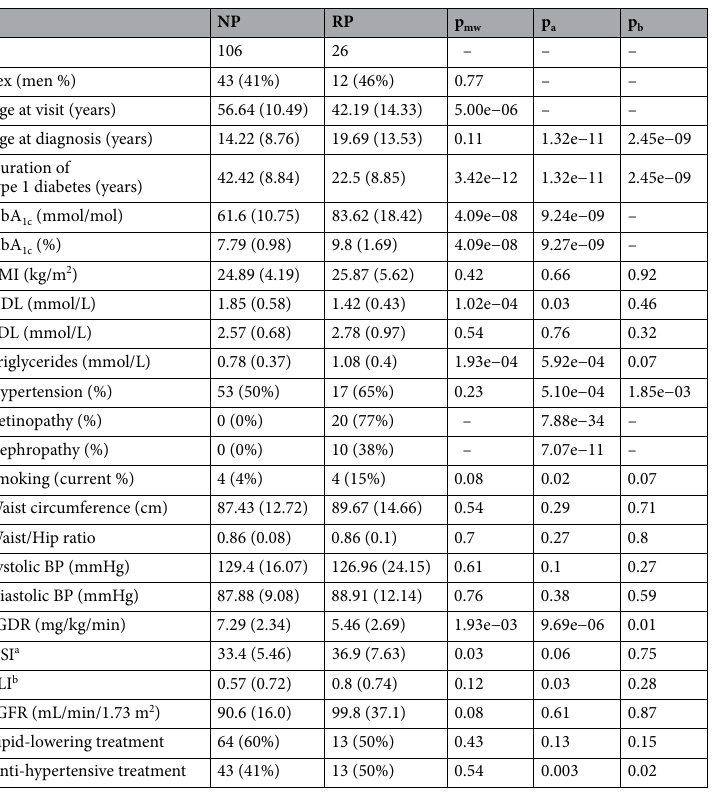
Table 1. Clinical characteristics of the PROLONG study participants. eGDR estimated glucose disposal rate, HSI hepatic steatosis index, FLI fatty liver index, eGFR estimated glucose filtration rate, p mw p-value from Mann–Whitney test, p a p-value from sex- and age-adjusted linear regression, p b p-value from sex, age and HbA 1c -adjusted linear regression. a n NP = 105 and n RP = 25. b n NP =